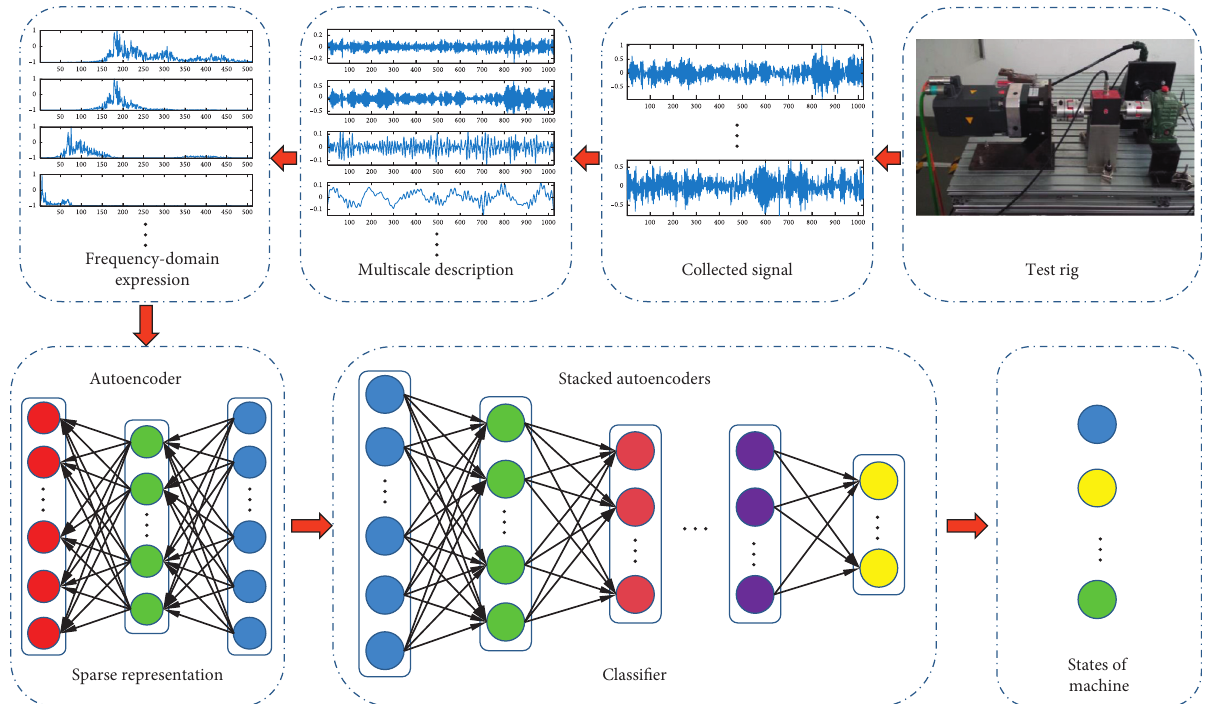
Figure 1: Flowchart of fault diagnosis based on the developed DCWT-SSAE